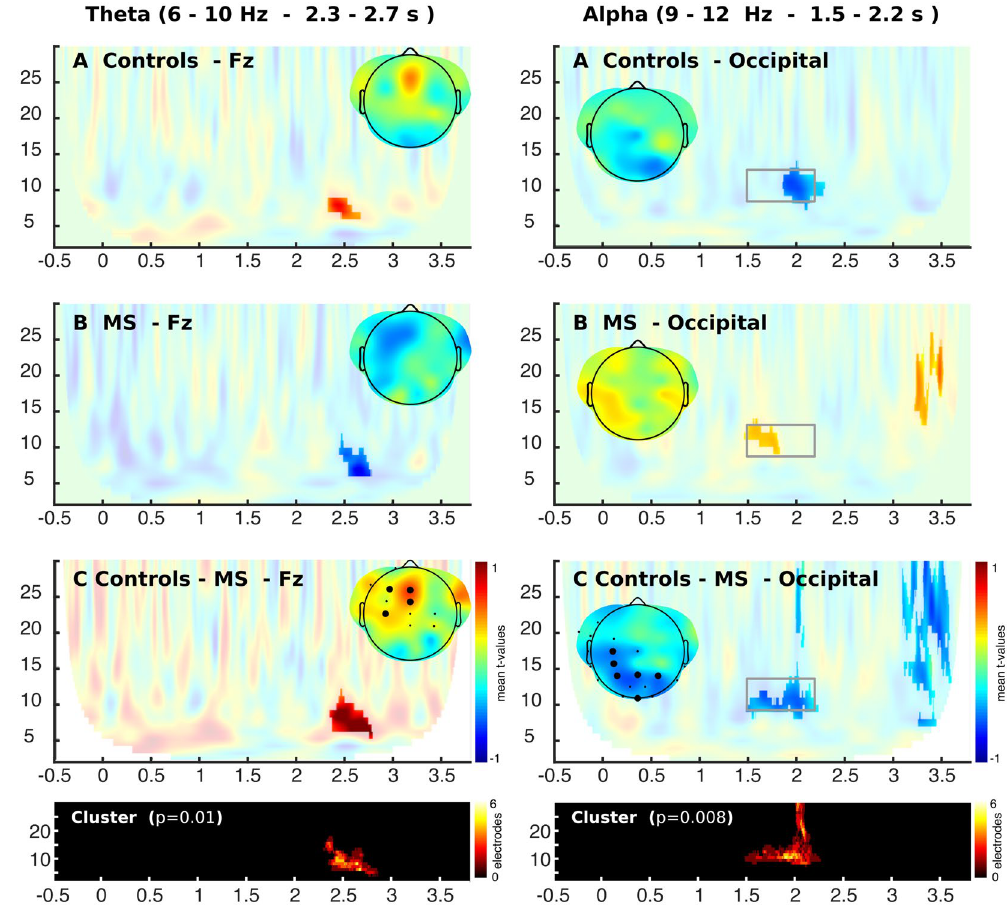
b2 * ML + b3 * SMP). Significant regions are highlighted (CBP test p <